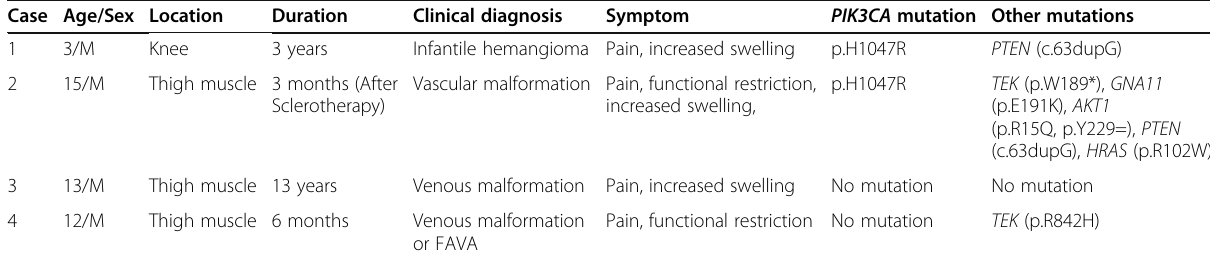
Table 1 Clinical and molecular genetic summary of the patients Case Age/Sex